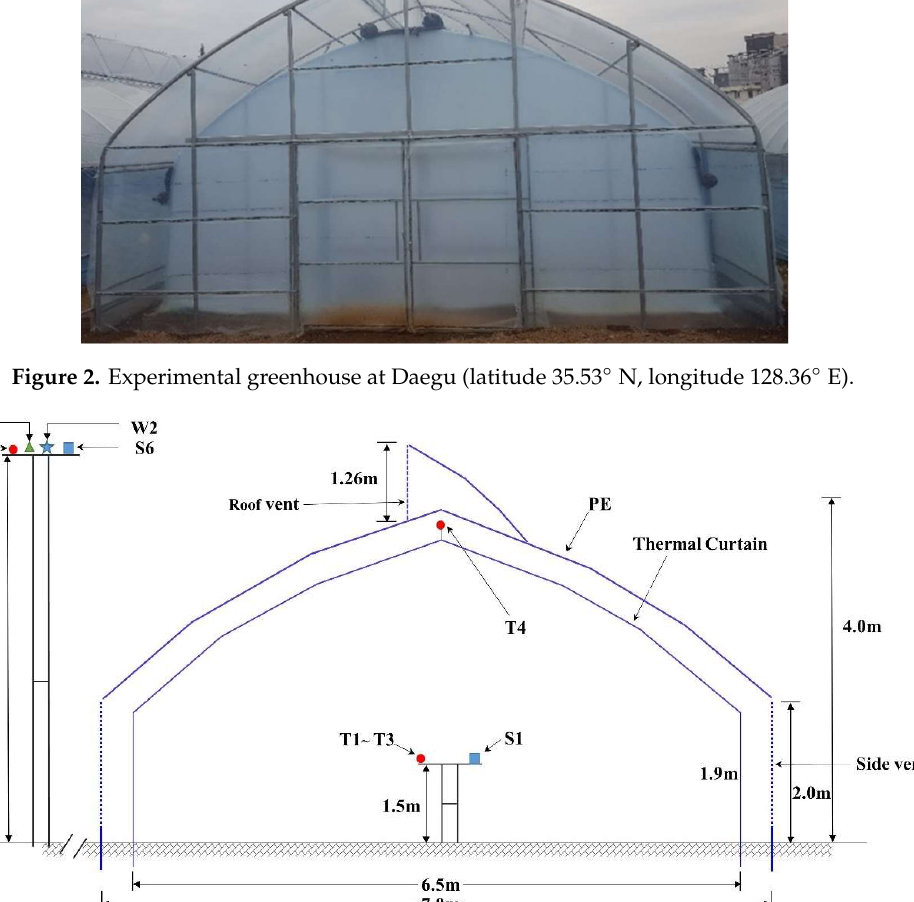
Figure 1. Geographic location of experimental greenhouse site.